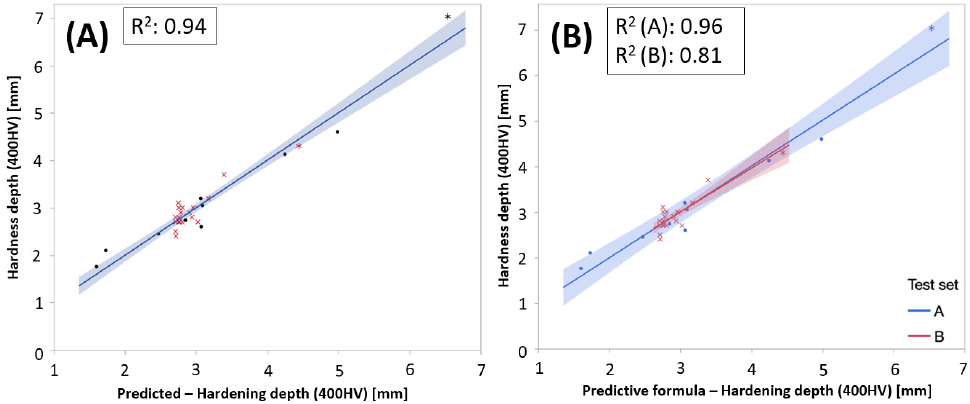
Figure 15. ( A ) Actual vs. predicted plot for the developed model and ( B ) stratified on test sets.